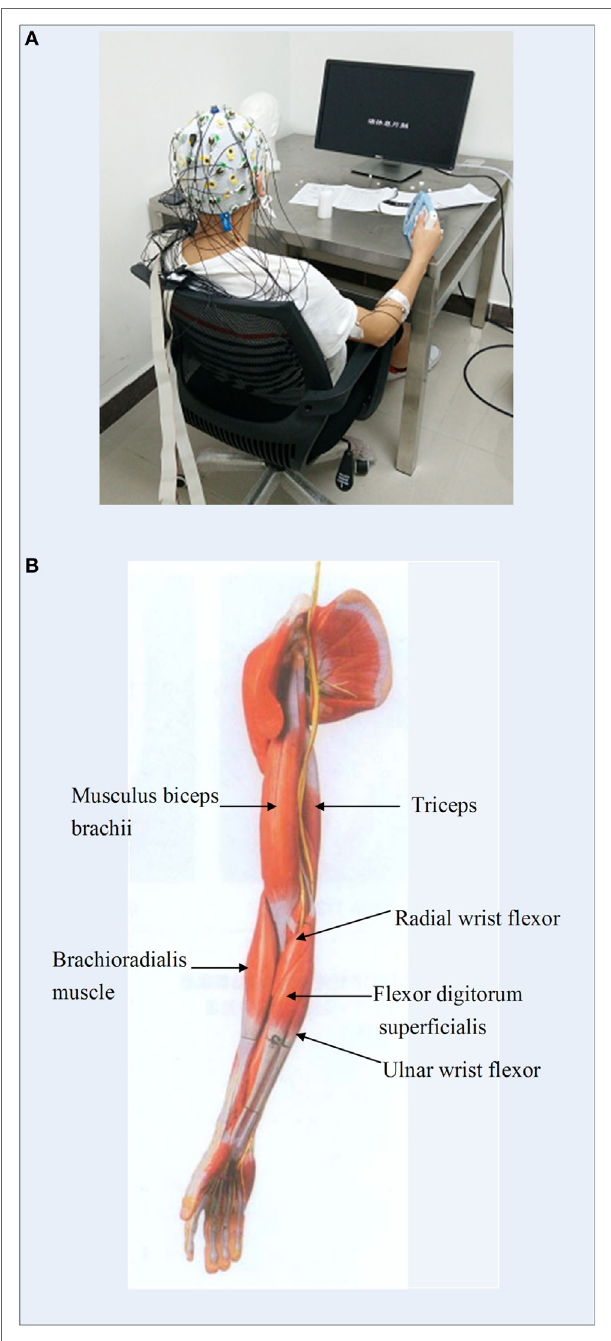
FigUre 2 | (a) Experimental environment of the electroencephalogram and electromyography (EMG) data measurement; (B) illustration of the locations of EMG electrodes on upper limb.